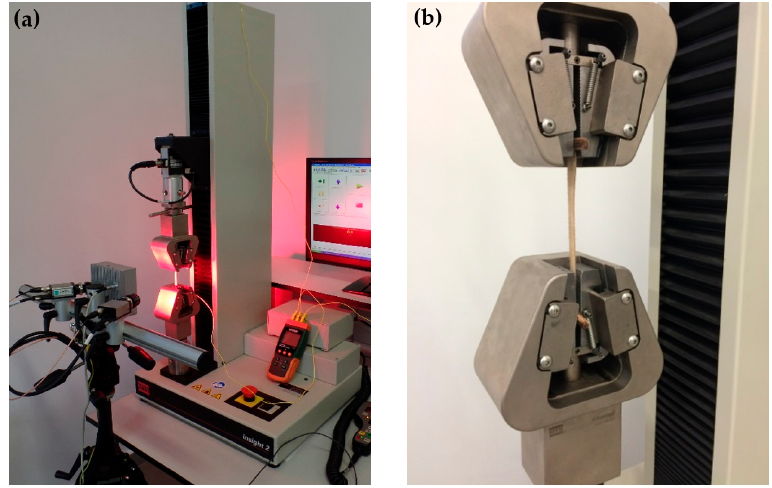
Figure 1. ( a ) strength testing machine; ( b ) a method of fixation of a sample in the